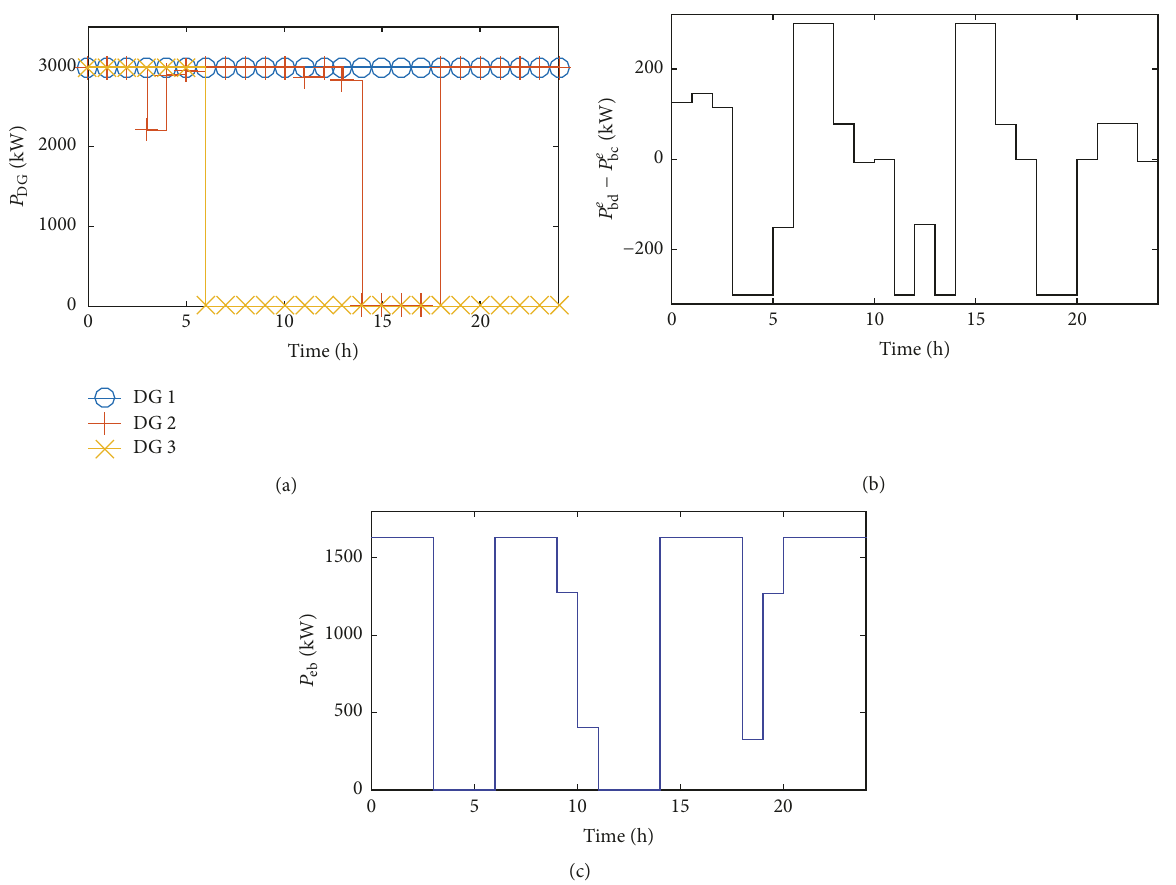
Figure 3: Scenario 1: (a) dispatch values of DG 1, DG 2, and DG 3, (b) BESS charge and discharge profiles, and (c) 𝑃 eb . Table 2: Cost breakdown and computational times for Scenarios